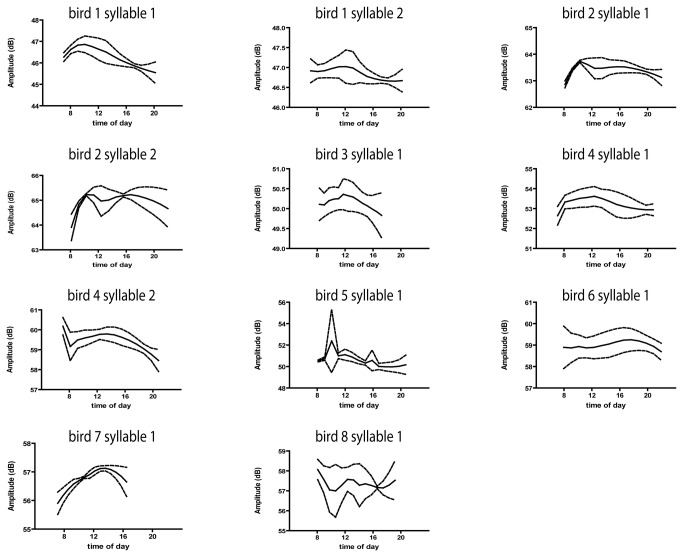
Amplitude of harmonic stacks, and of harmonic subsyllabic elements, follows a daily oscillation, albeit with substantial variation and noise.Averaged daily RLOESS fits of amplitude (± 1 SD) for 11 syllables from 8 animals. Average number of days = 4.82 ± 0.60.